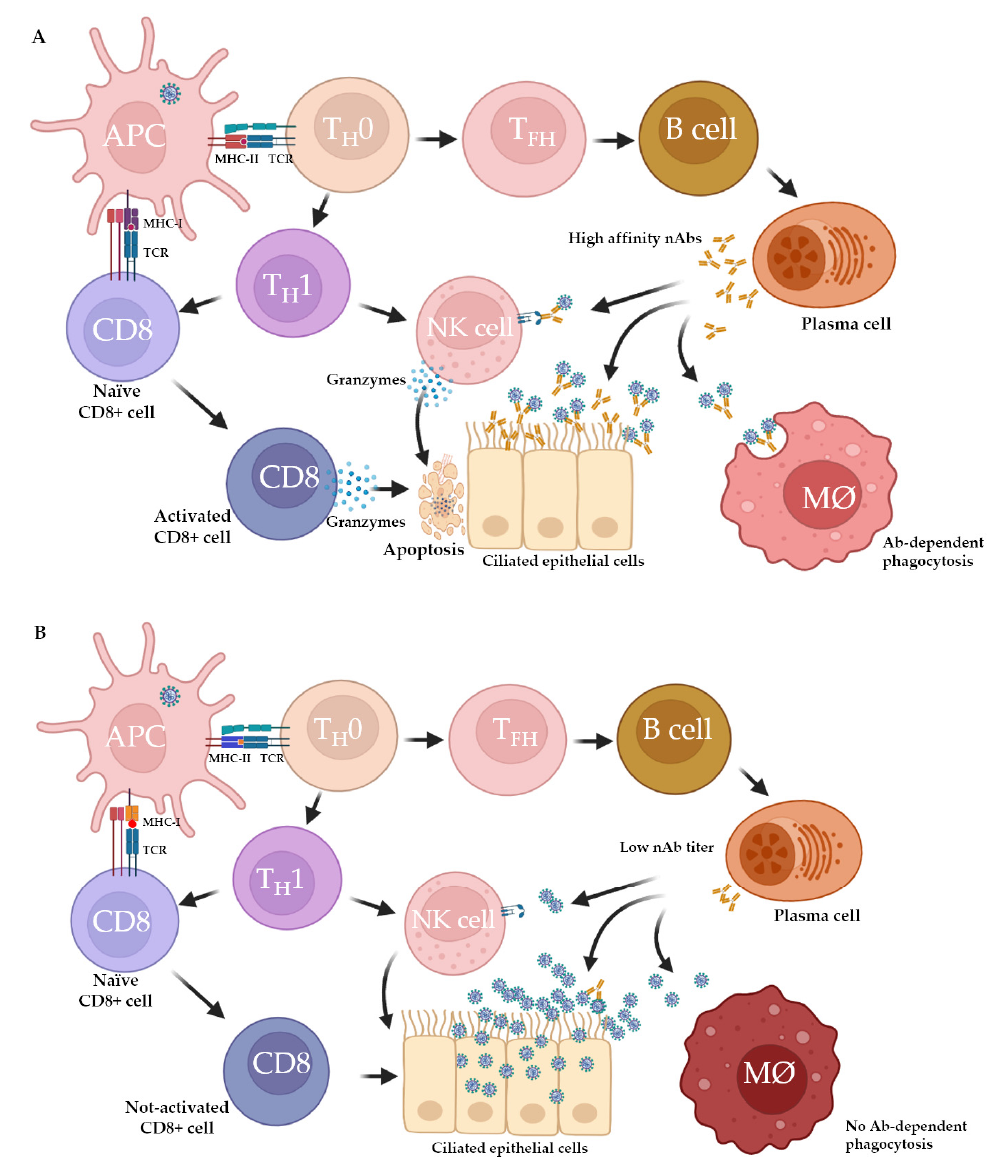
Figure 1. HLA variation determines SARS-CoV-2-specific antibody response. In this example, we present different scenarios suggesting differential SARS-CoV-2-specific antibody response impacted by variation in the HLA class II molecule. ( A ) MHC-II molecule binding to SARS-CoV-2 peptides induces efficient CD4+ T cell and antibody response leading to viral neutralization, ADCC, and the death of SARS-CoV-2 infected cells. ( B ) Polymorphic MHC-II molecule binding to viral peptide fails to stimulate CD4+ T cells and results in low antibody titer, lack of ADCC, and ADP. Abbreviations: Ab: antibody; ADCC: antibody-dependent cellular (NK cell) cytotoxicity; ADP: antibody-dependent phagocytosis; HLA: human leukocyte antigen; MØ: macrophage; MHC: major histocompatibility complex; nAbs: neutralizing antibodies; TH0: CD4+ helper cells; TH: T helper; TFH: T follicular helper cells. Figure made using BioRender.